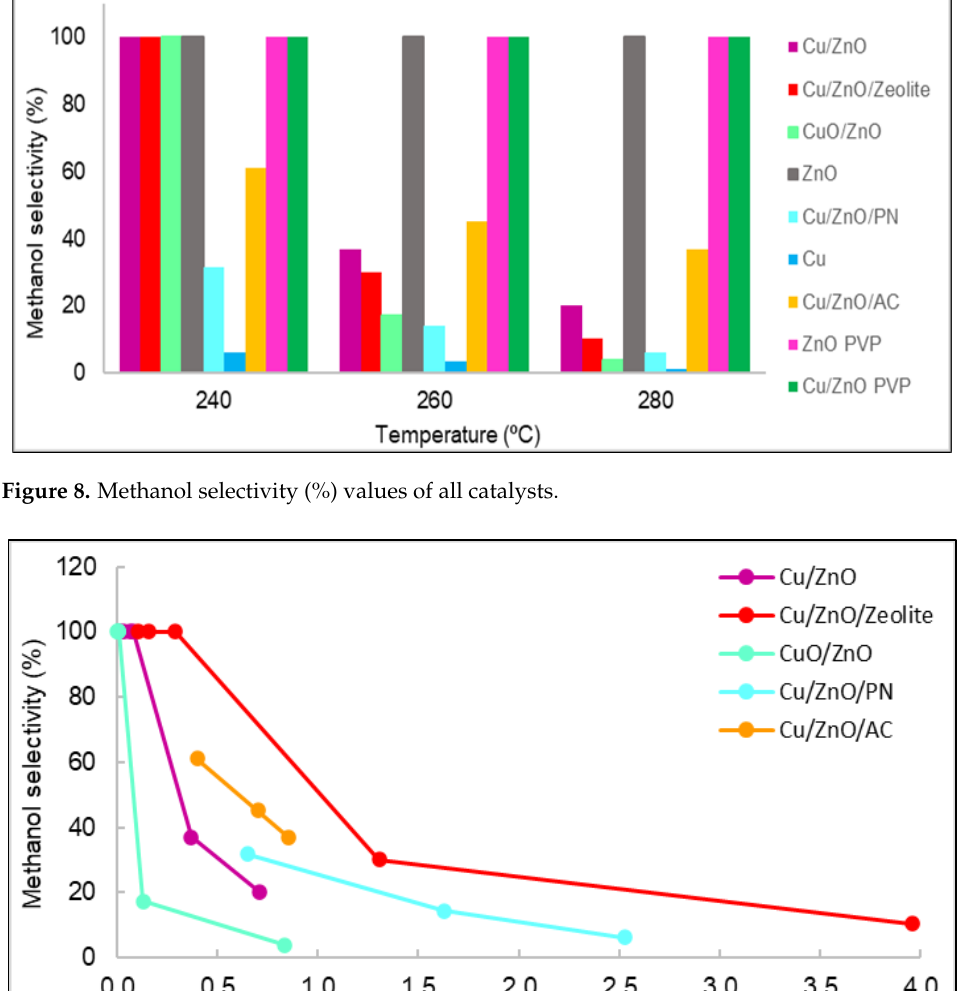
Figure 8. Methanol selectivity (%) values of all catalysts.